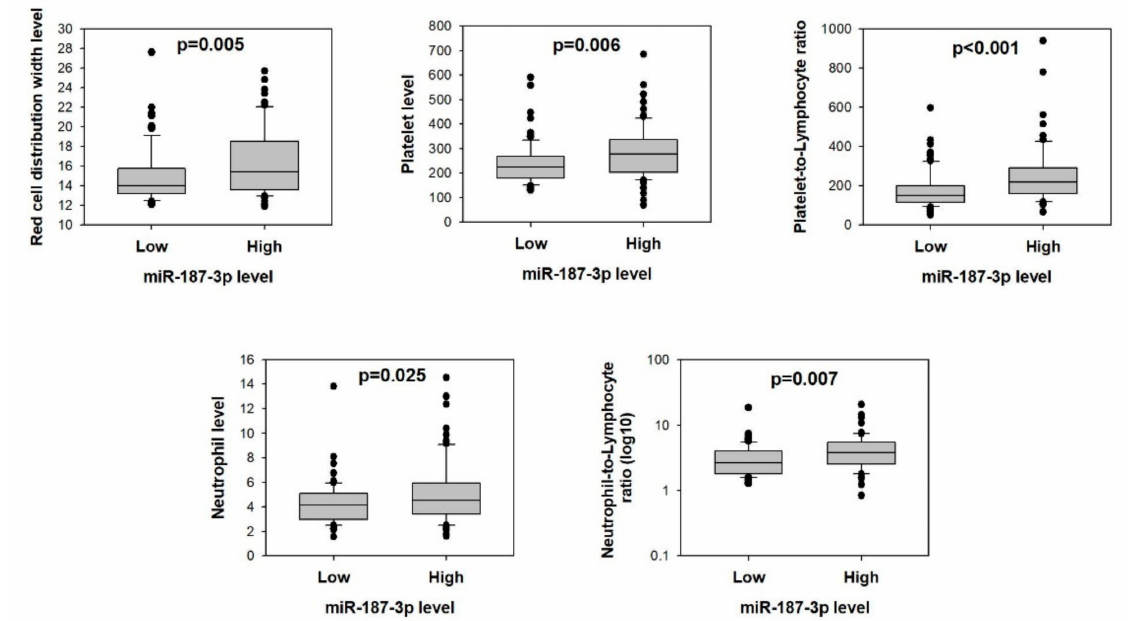
Figure 8. Higher preoperative peripheral inflammation-related blood parameters in CRC patients with higher tumor miR-187-3p levels: Comparison of red cell distribution width, platelet count, platelet-to-lymphocyte ratio, neutrophil count, and neutrophil-to-lymphocyte ratio between CRC patients with high or low tumor miR-187-3p levels in the validation cohort ( n =